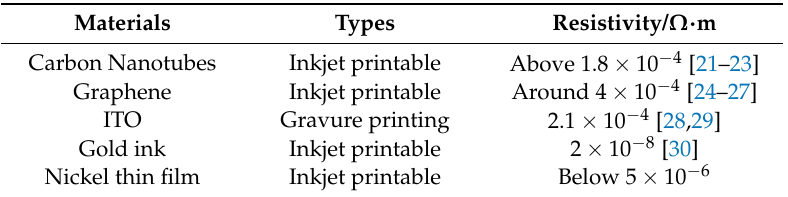
Table 1. Properties of conductive inks for